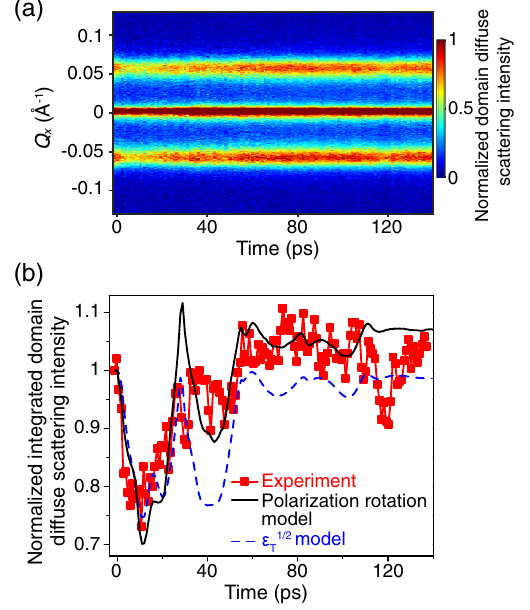
FIG. 3. Picosecond dynamics of polarization distortion in nano- domains. (a) Domain diffuse scattering intensity as a function of time following optical excitation and wavevector Q x . (b) Time dependence of measured (squares) and simulated (lines) normal- ized domain diffuse scattering intensity. The solid and dashed lines represent simulations based on the enhanced polarization response with n ¼ 1 . 1 , termed the polarization rotation model, and the response expected with a uniformly polarized tetragonal ferroelec- tric ( n ¼ 1 = 2 ), termed the ε 1 = 2 T